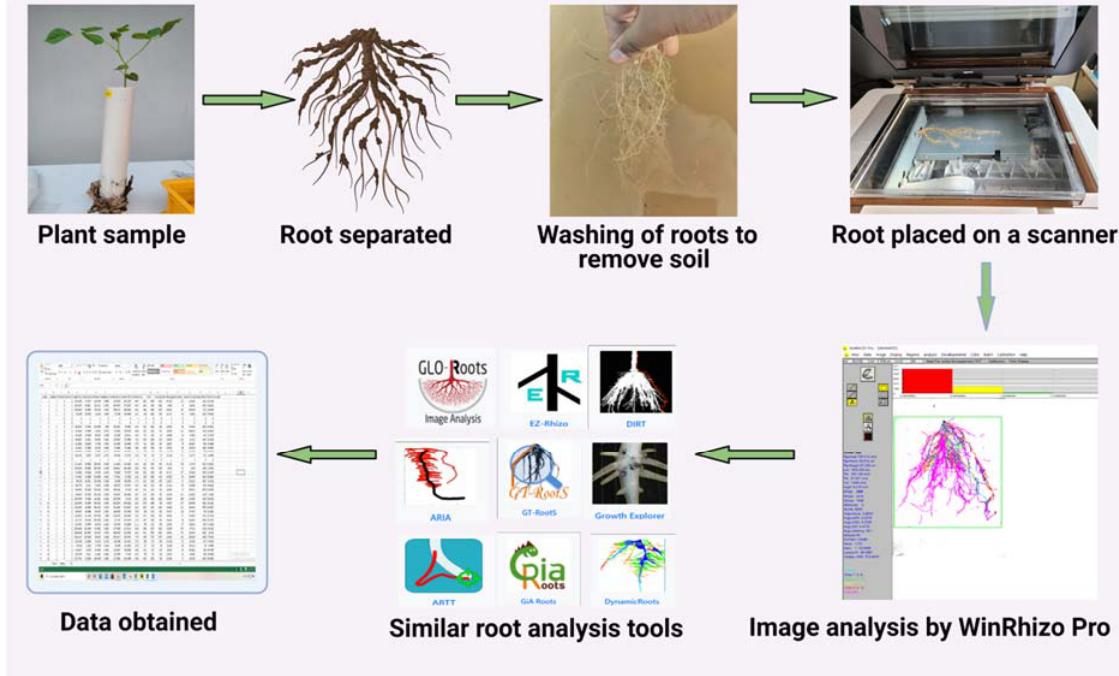
Figure 3. Plant root-analysis methods available for morphological and architectural analysis of roots and applicable to different plants. Methods can range from the use of advanced scanners to image-based root analysis. Created with BioRender.com.